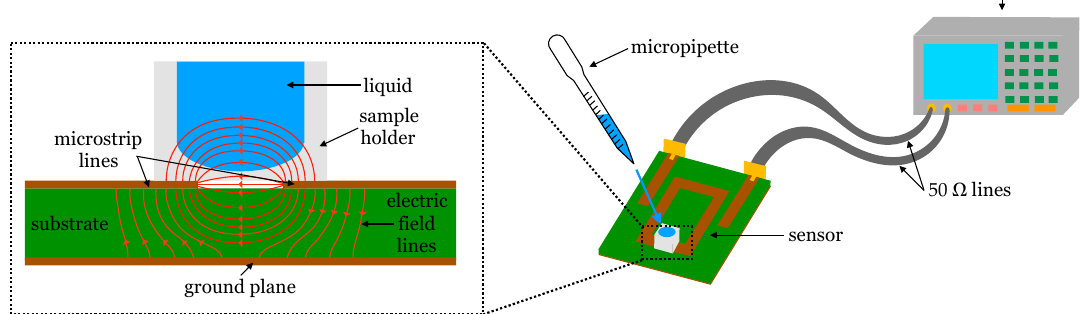
Figure 1. Illustration of the interaction of the electric field with the liquid under measurement, and of the measurement setup.